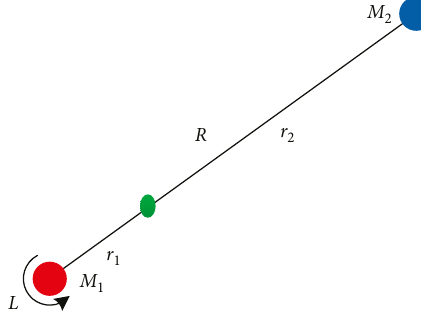
Figure 3: Diagram of the deorbiting system